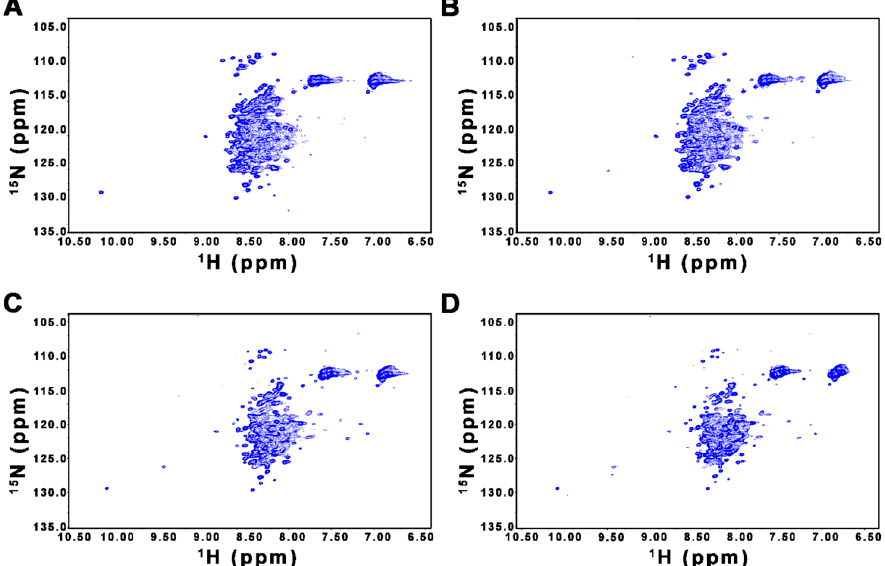
Figure 2. 1 H- 15 N HSQC spectra of FL-Nrf2 (20 μ M) in 50 mM ammonium acetate buffer, 0.5